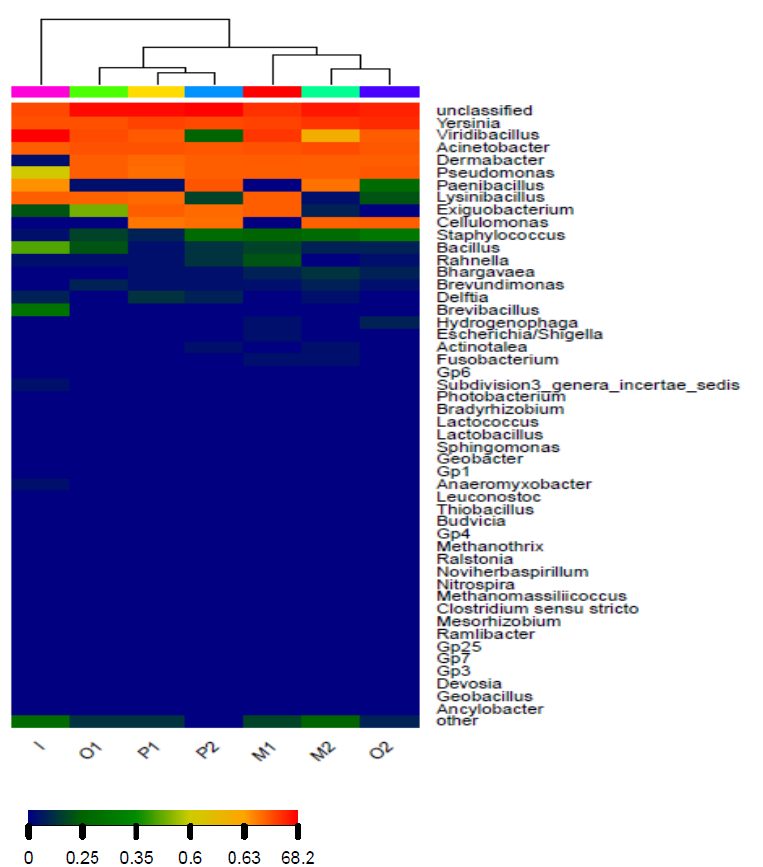
Figure 8. Hierarchical cluster analysis of different Cr (VI) reduction groups based on the relative abundance of the genus.